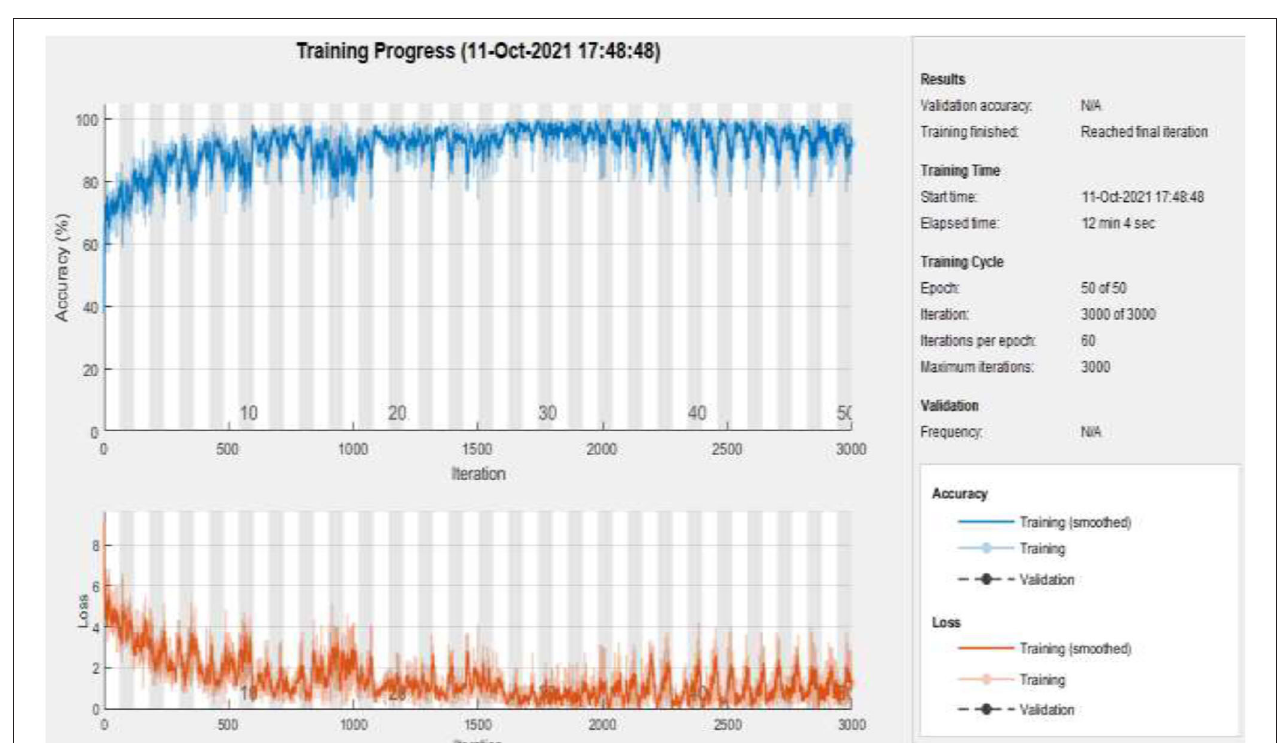
FIGURE 10 | Training of dataset B at 50